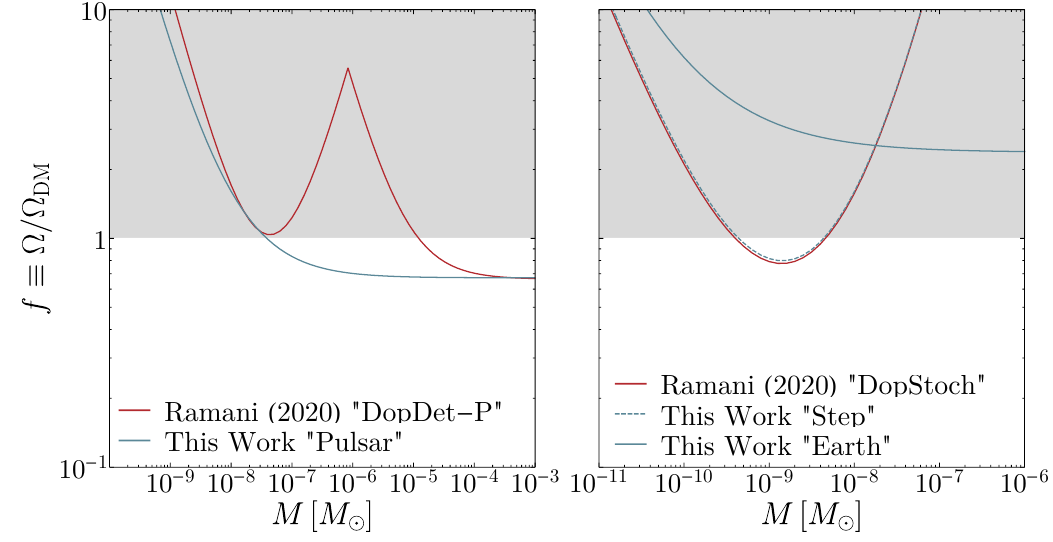
Figure 10 . Comparison of the PBH constraints between this work and [18]. The left panel compares the pulsar term results while the right panel compares the Earth term results. The meanings of the labels are described in the main text. The pulsar parameters used here are N t rms = 50 ns and T = 20 years . The SNR thresholds are set to SNR = 4 for the pulsar term and SNR = 2 for the earth term for consistency with